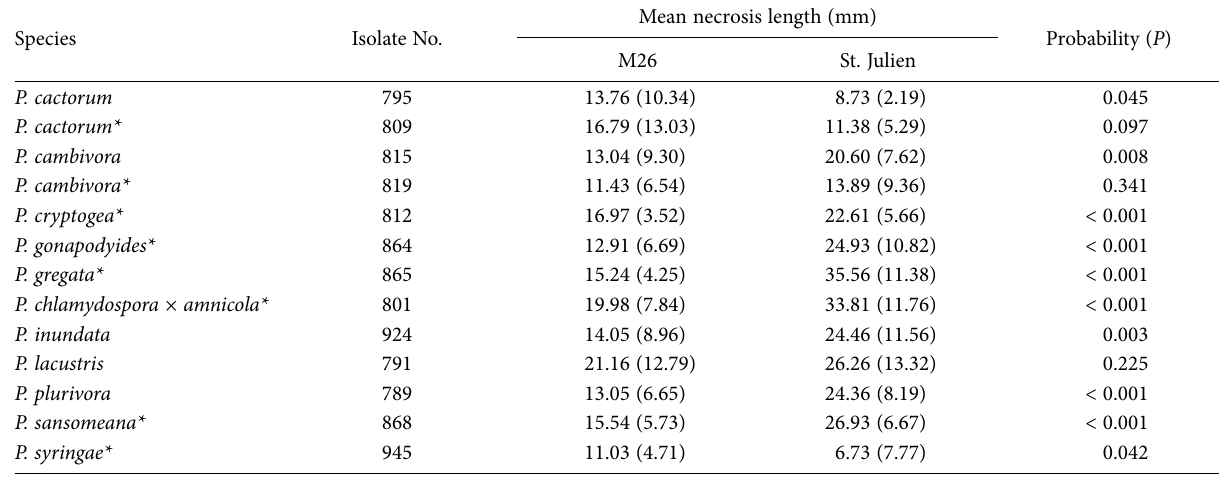
Table 3. Mean necrosis lengths (median and standard deviations) caused by individual isolates (isolates from pome fruit are marked by the symbol *) on ´M26´ and ´St. Julien´ rootstocks and differences in pathogenicity toward both rootstocks.